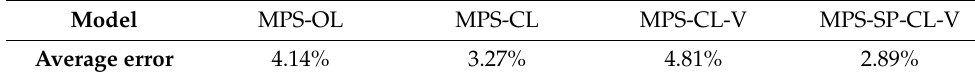
Figure 8. Time histories of the hydrostatic pressure on point A. Table 2. Average error on point A between 2 and 3 s.